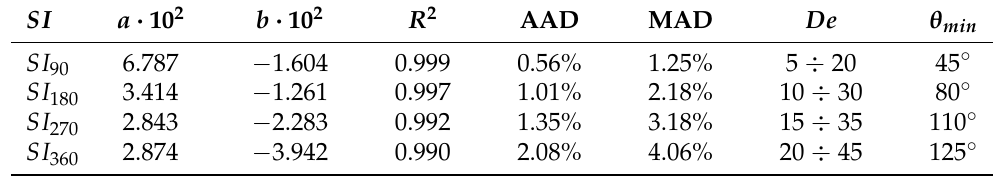
Table 2. Fitting coefficients (7), analyzed ranges of the De numbers, and the minimum angle θ min